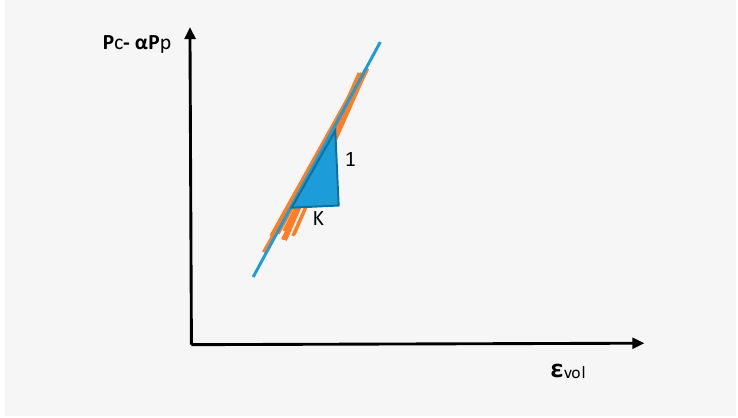
Figure 3. A typical matched curve for variation of P c − α P p vs. ε vol during a jacketed test. K Jac is calculated using the slope of the fitted line. α is also calculated from the P c − α P p axis in Figure 3. Finally, the solid bulk modulus of the matrix mineral can be measured from the Equation (3).